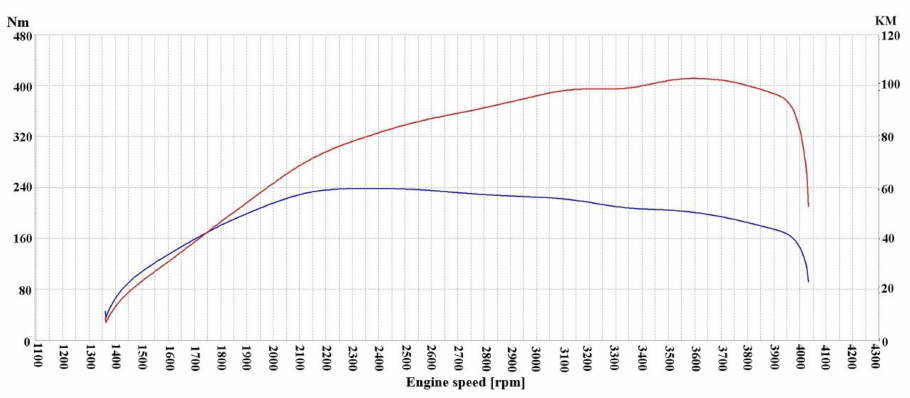
Figure 1. Characteristics of the test engine.